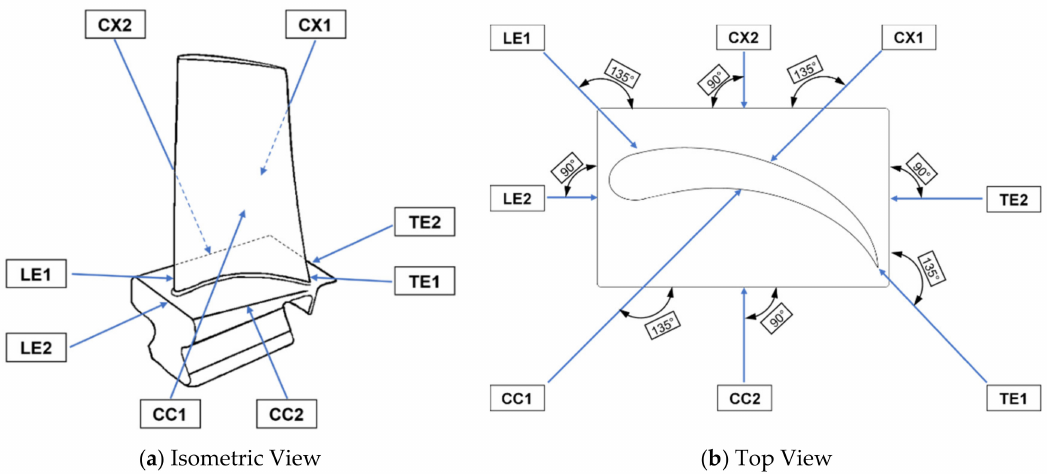
Figure 6. Schematic presentation of the different blade perspectives and its acronyms. ( a ) Isometric presentation of the blade, ( b ) presentation of the blade from the top.